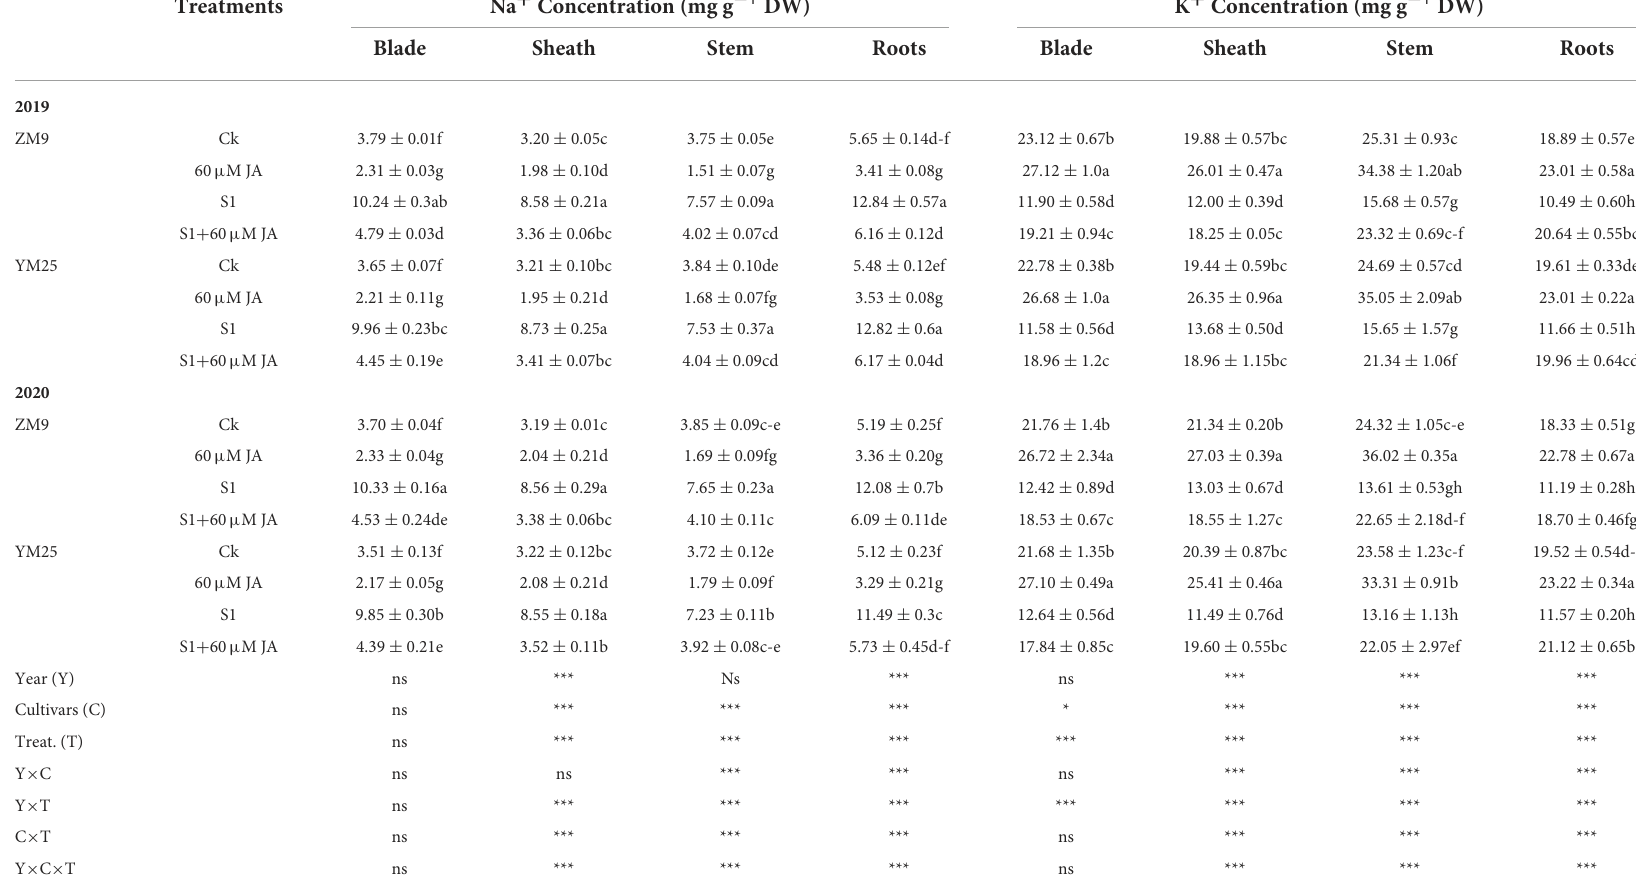
TABLE 3 Effects of JA priming on Na + concentration and K + concentration in the leaf blade and sheath, stem, and root of two wheat cultivars Mai9 (ZM9, salt-sensitive) and Yang Mai25 (YM25, salt-tolerant) under control and salinity stress conditions during two consecutive growing seasons 2019 and 2020.